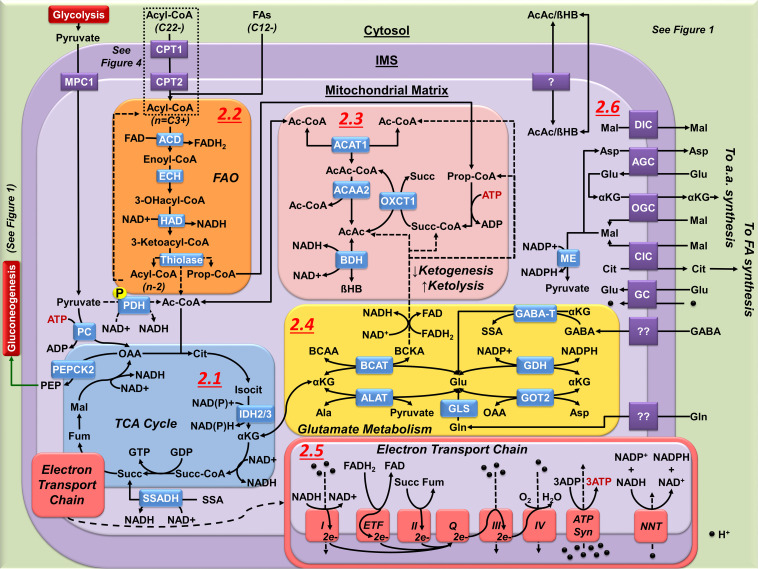
Mitochondrial metabolism in astrocytes. (2.1) The astrocyte TCA cycle is principally used for biosynthetic processes, not OXPHOS. Synthesis of Ac-CoA from pyruvate is limited by the phosphorylation (P) of PDH. Cataplerotic reactions of the TCA cycle are matched by anaplerotic carbon inputs. Anaplerotic inputs in astrocyte include pyruvate carboxylatyion to OAA; Ac-CoA and Succ-CoA synthesis from FAO and ketolysis; and metabolism of glutamate to αKG via transamination reactions or by the activity of GDH. Astrocyte cataplerotic outputs include PEP (gluconeogenesis) αKG, malate (Mal), and citrate (Cit). Fum, fumarate. (2.2) FAO produces Ac-CoA and Prop-CoA that are directed to either ketogenesis, ketolysis, or as anaplerotic input to the TCA cycle. FAO generates a high yield of NADH and FADH2 (see
2.5). (2.3) Ketogenesis condenses Ac-CoA to either AcAc or βHB. FAO is the principal source of ketogenesis in astrocytes. Ketolysis reverses this process, requiring Succ-CoA from either Prop-CoA (FAO or BCAA metabolism), or the TCA cycle as a driving force. (2.4) Mitochondrial Glu synthesis and incorporation into the TCA cycle in astrocytes is performed by transamination (GOT2, ALAT, BCAT) or by deamination (GDH, GLS, GABA-T) of αKG allowing glutamate to act in both cataplerosis and anaplerosis. (2.5) The astrocyte ETC is not required for survival, and its activity has been reported to be a source of ROS due to inefficient complex activity and electron transfer. Importantly, high yield of NADH and FADH2 generated from FAO (see 2.2) can increase ROS formation due to the transfer of electrons from FADH2 to ETF, creating a backpressure of electrons flowing from complex I. (2.6) While the outer mitochondrial membrane is fairly permeable, numerous transporters exist on the inner membrane to facilitate entry and exit of a number of metabolites from the mitochondrial matrix.